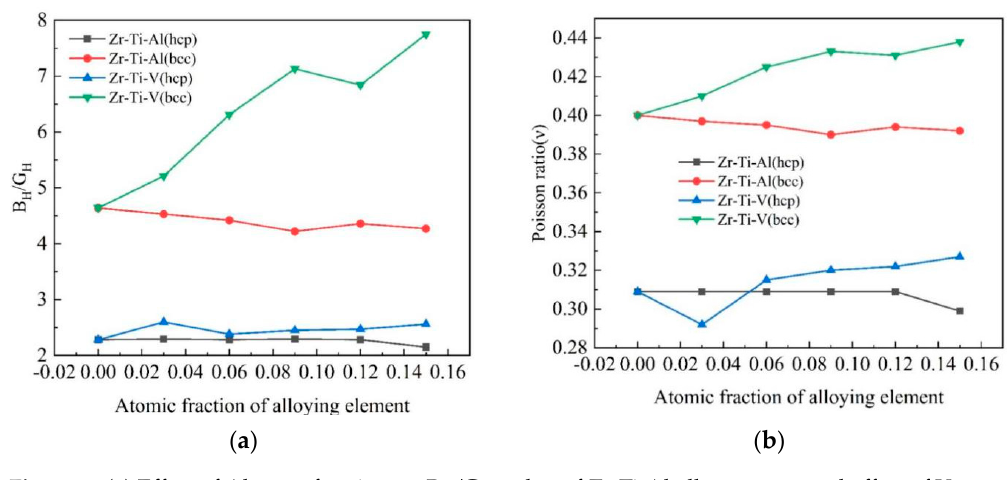
Figure 7. ( a ) E ff ect of Al atom fraction on B H / G H value of Zr-Ti-Al alloy system and e ff ect of V atom Figure 7. ( a ) Effect of Al atom fraction on B H /G H value of Zr-Ti-Al alloy system and effect of V atom